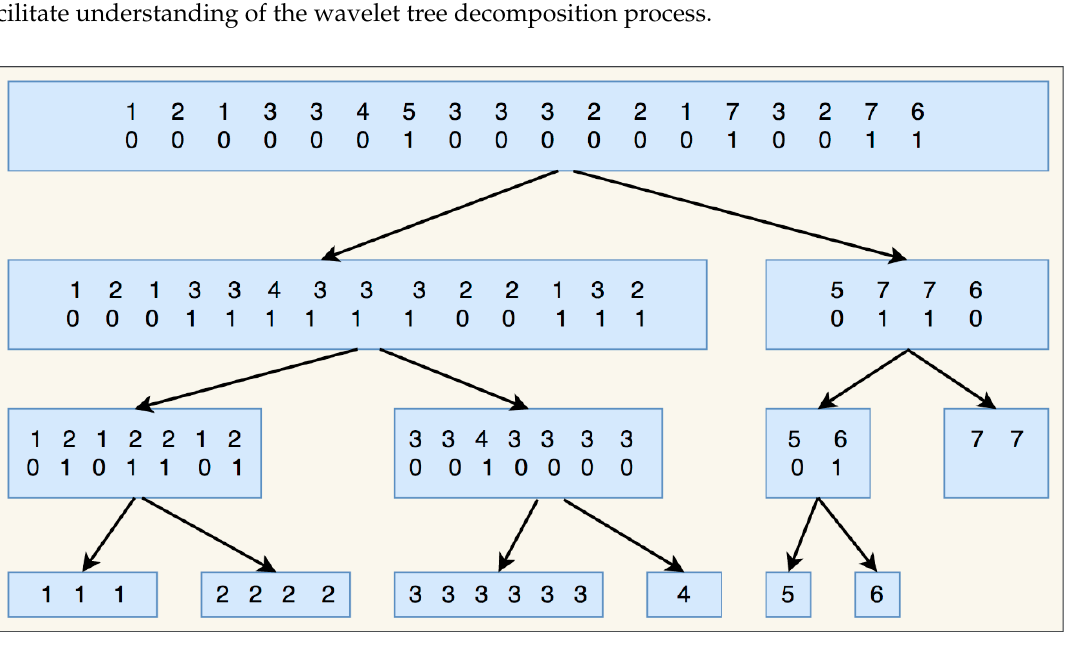
Figure 4. Wavelet tree example, with 0 for first half and 1 for second half of the 03B1bet.